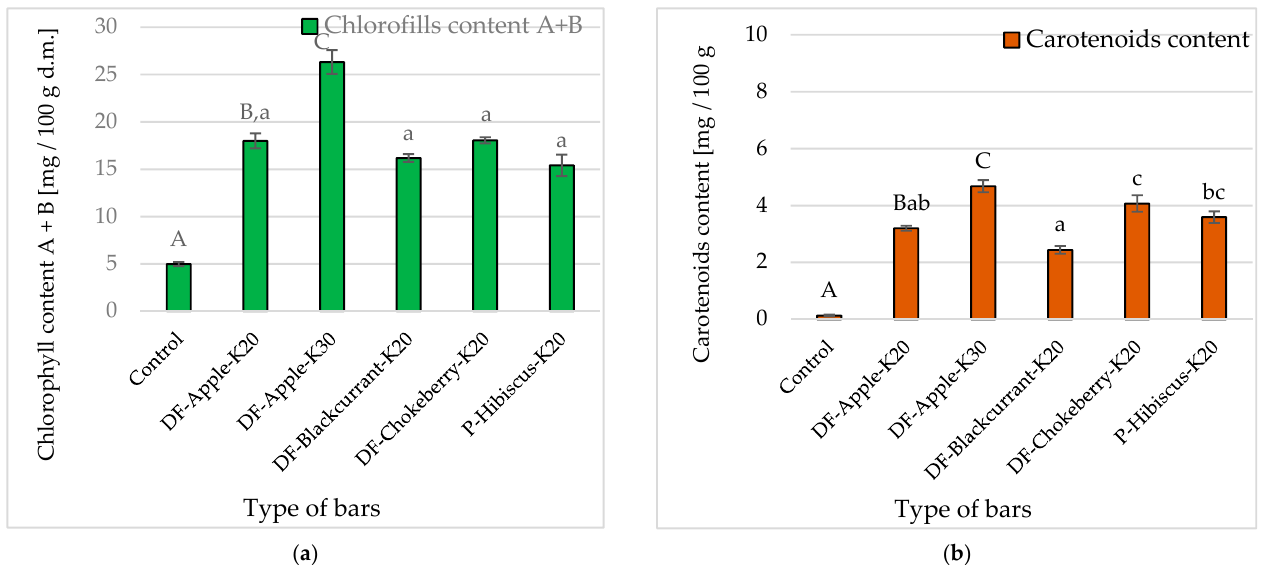
Figure 4. The influence of the kale (factor I) and fibre preparations (factor II) addition in multigrain bars on the: ( a )— chlorophyll content A + B [mg/100 g d.m.] and ( b )—carotenoids content [mg/100 g d.m.]. Designations: A, B, C—homogeneous groups (factor I), and a, b, c—(factor II) at α = 0.05. The bar codes are explained in Table 4.